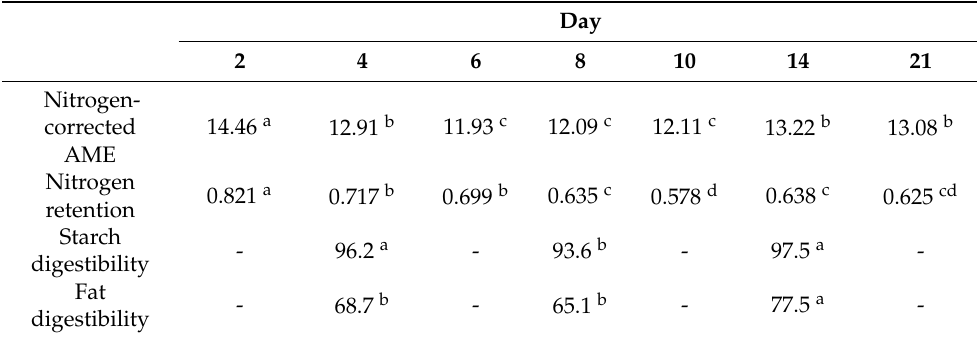
Table 3. Changes in the nitrogen-corrected apparent metabolizable energy (AME n ; MJ/kg dry matter), nitrogen retention (% intake), and total tract digestibility (%) of starch and fat in maize–soybean meal-based diets for broiler chicks during the first 21 days